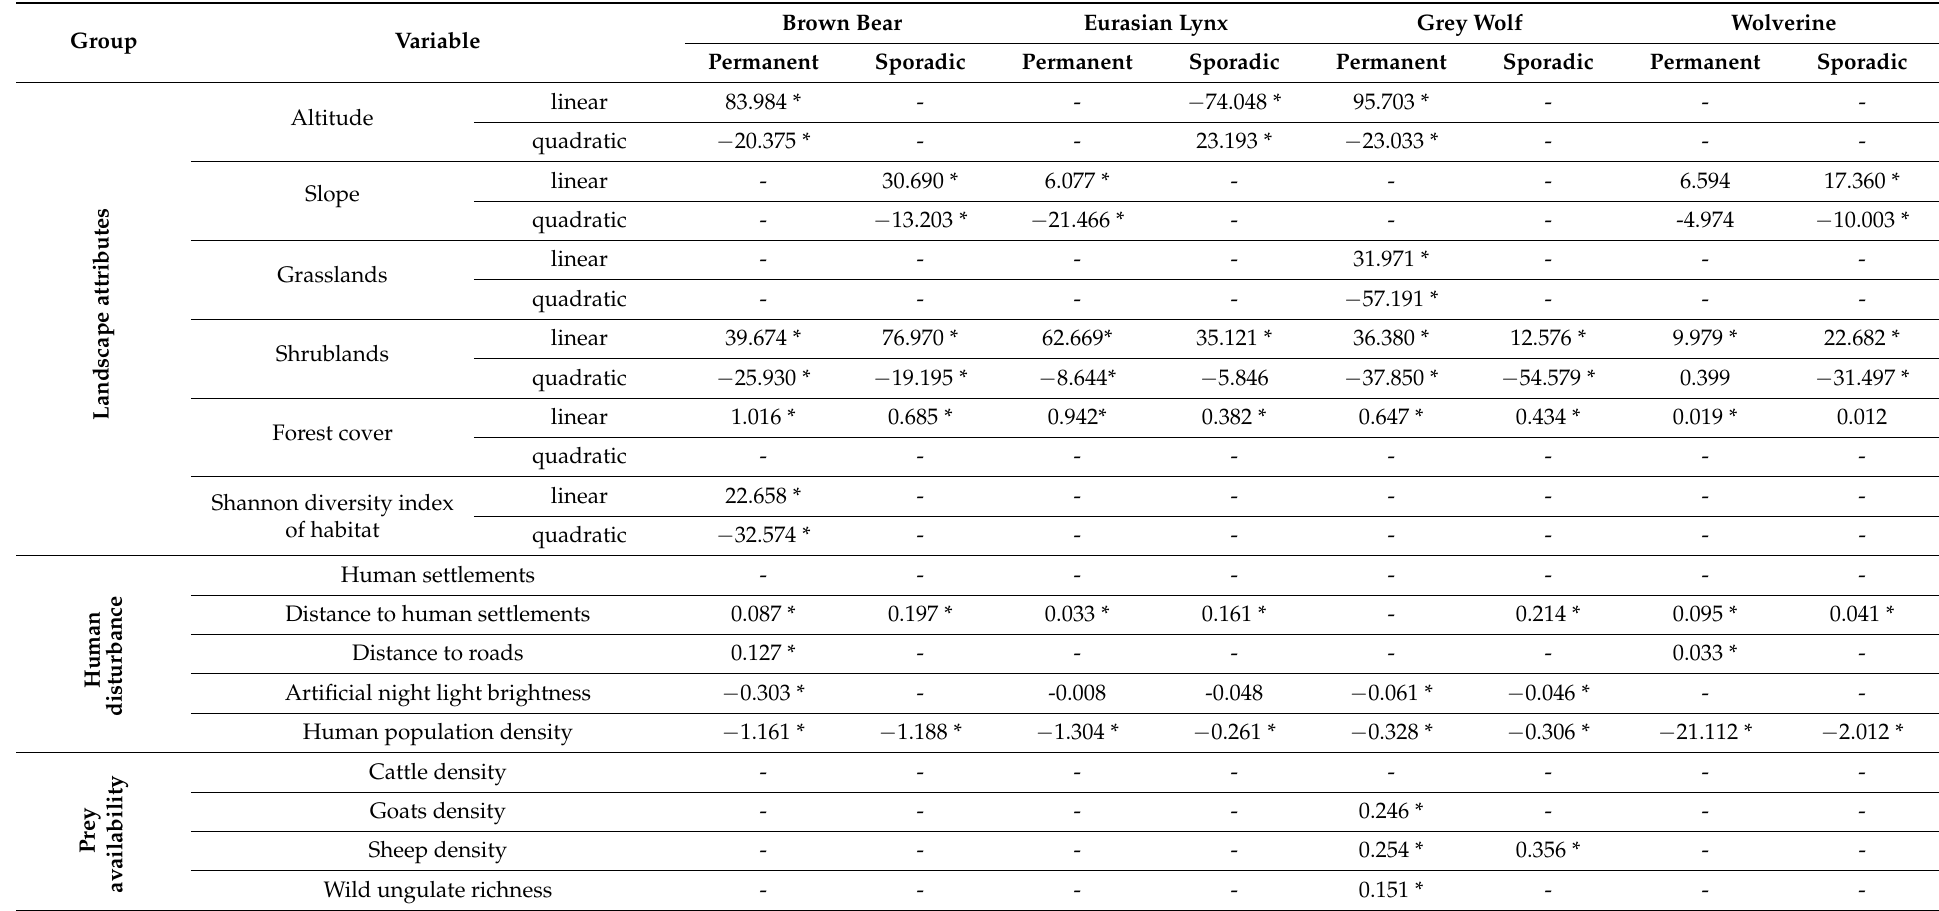
Table 2. Beta coefficients of generalized linear models carried out on permanent and sporadic occurrences of the four large carnivores in Europe in relation to the predictor variables of landscape attributes, human disturbance and prey availability.